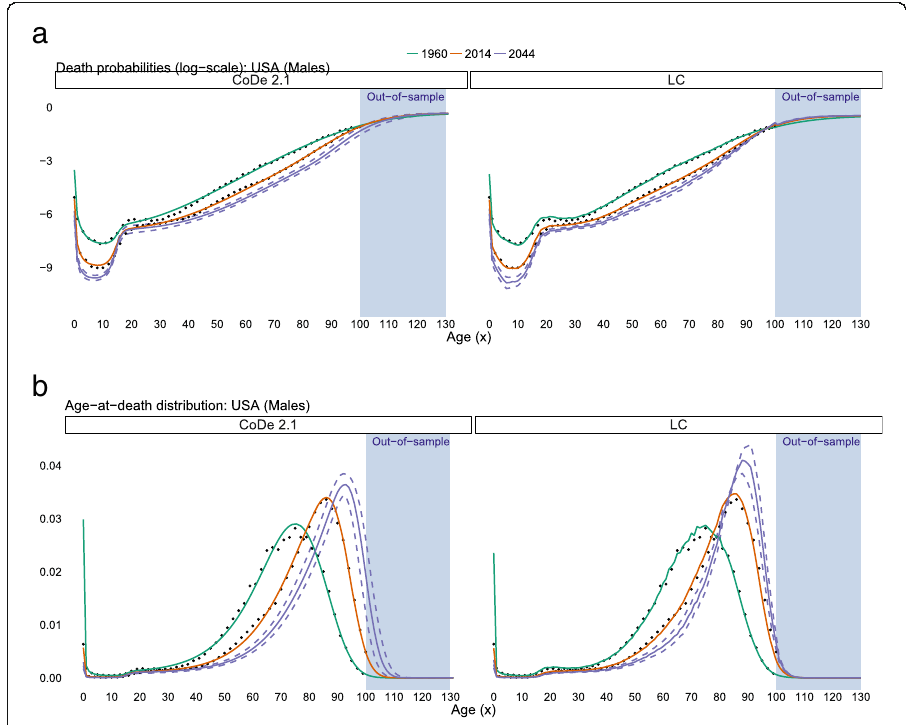
Fig. 2 Estimations and projections of the death probabilities and the age-at-death distribution for Japanese females for the years 1960, 2014, and 2044 and for ages 0 – 130. CoDe 2.1 (left) and LC (right). The dashed lines are 95% projection intervals. The reference period is 1960 – 2014 for ages 0 –